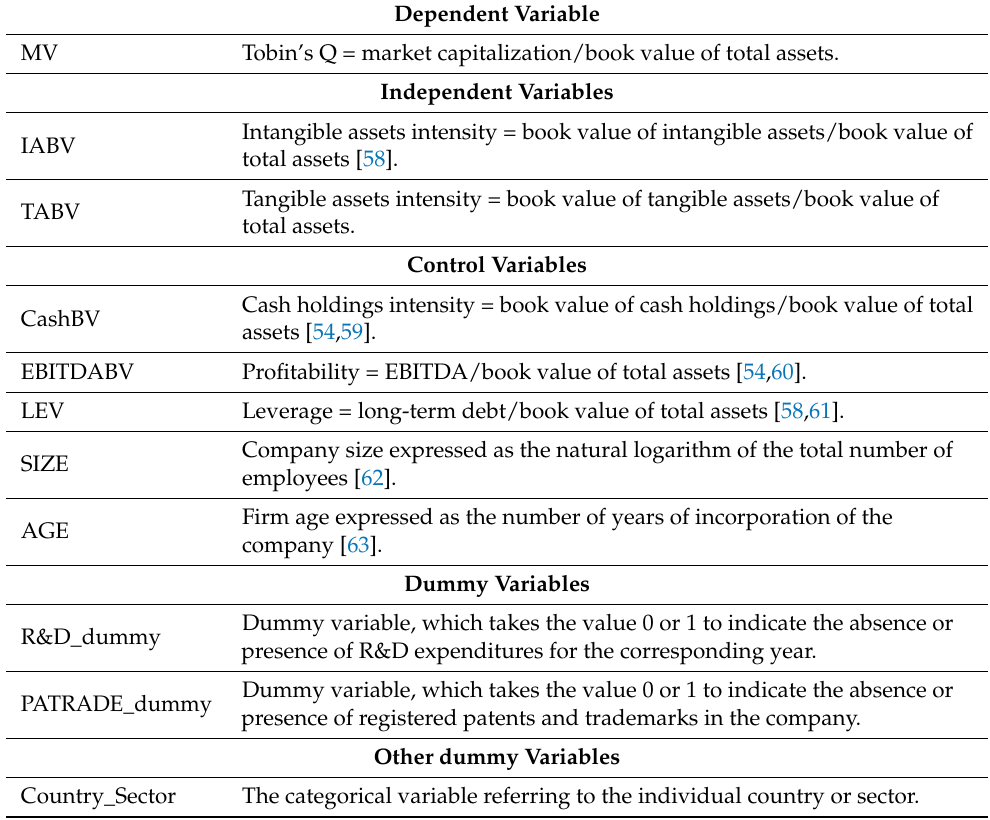
Table 1. Dependent and independent